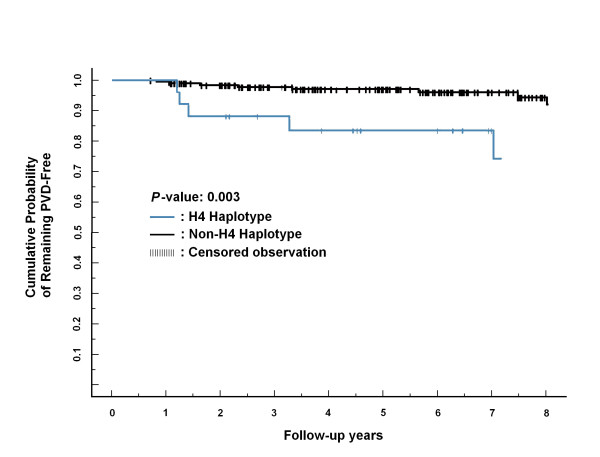
Cumulative probability of PAD in type 2 diabetic patients with and without haplotype H4.